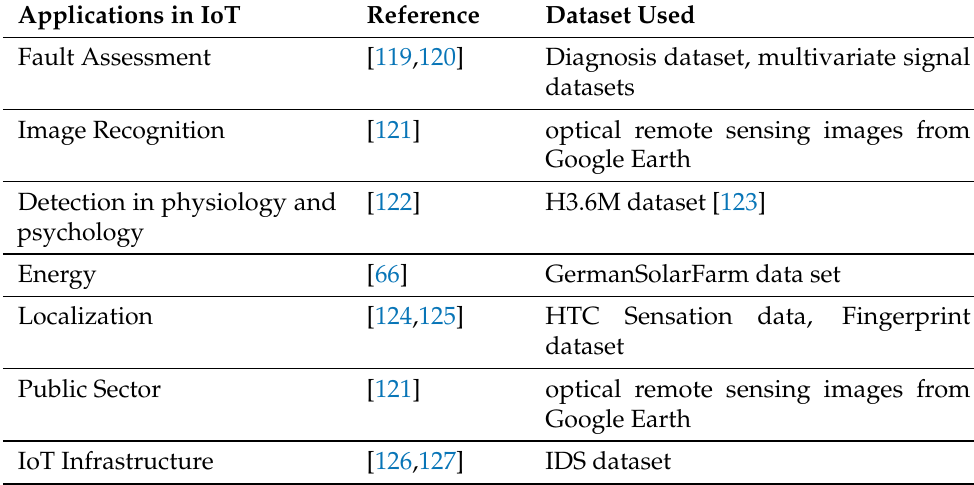
Table 4. AE Model in IoT